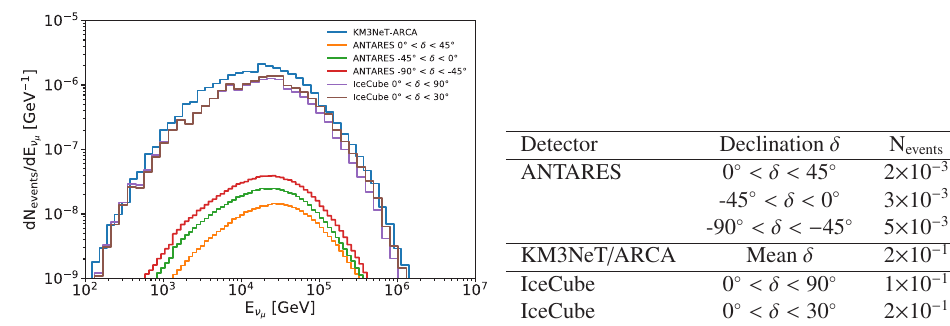
Figure 1: Number of events per energy bin in- duced in neutrino telescopes by ν µ from an indi- vidual choked GRB.